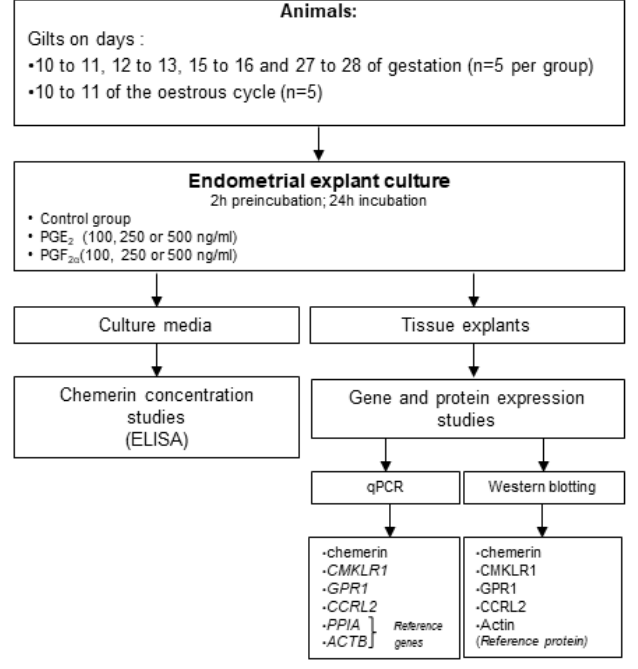
Figure 9. Experimental design graph.